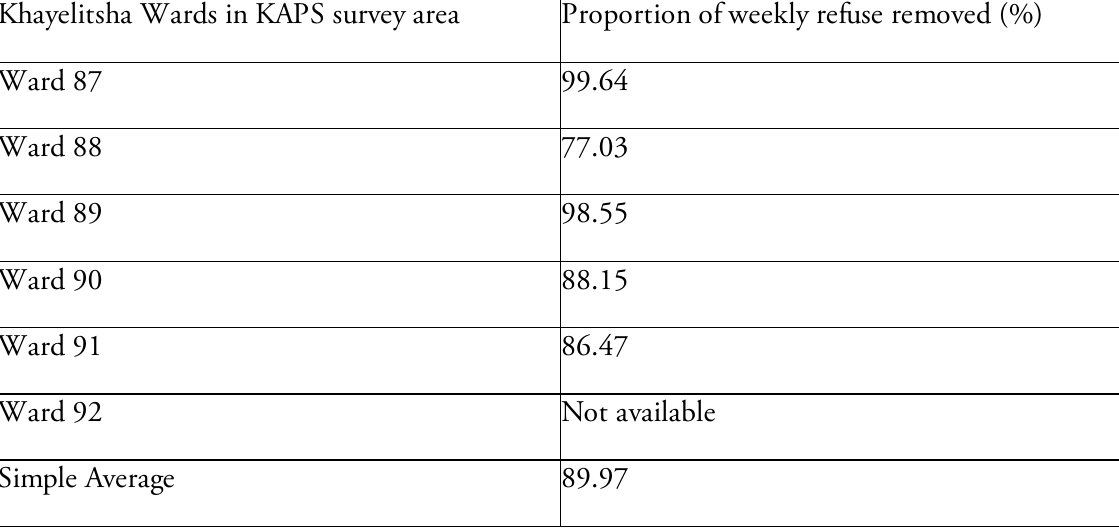
Table 8: Proportion of refuse removed by local authority at least once a week: 2005/2006 Khayelitsha Wards in KAPS survey